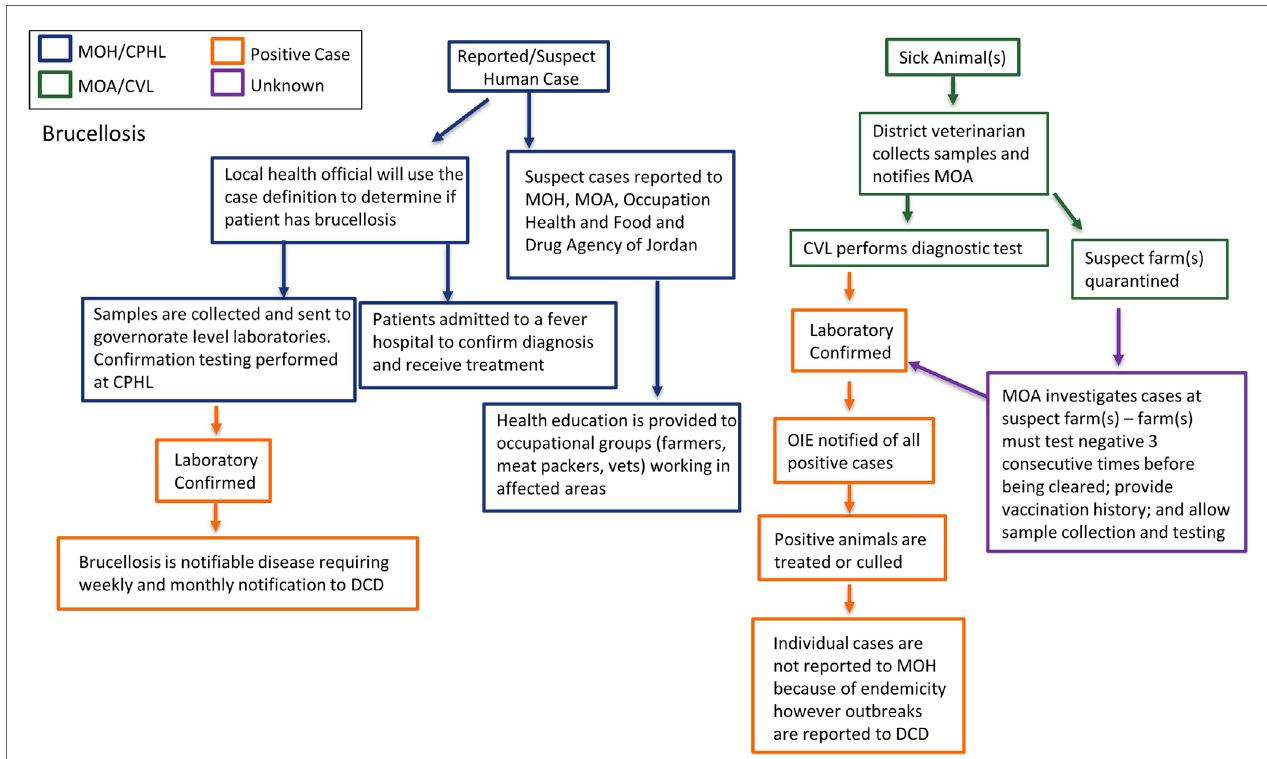
FigUre 5 | surveillance and laboratory mapping of brucellosis . Surveillance and laboratory networks for brucellosis, including nodes of communication and response, were mapped across human health and veterinary sectors. Systems were analyzed beginning from report of a suspect case to diagnostic confirmation, including evaluation: case reporting; reporting and sample submission; laboratory testing; case management; and outbreak investigation. Efforts in surveillance and response lead by Ministry of Health are represented in blue while those lead by Ministry of Agriculture are in green. Positive cases are noted in orange while unknown/unconfirmed cases are represented in purple. Abbreviations: MOH, Ministry of Health; CPHL, Central Public Health Laboratory; DCD, Directorate of Communicable Diseases; MOA, Ministry of Agriculture; CVL, Central Veterinary